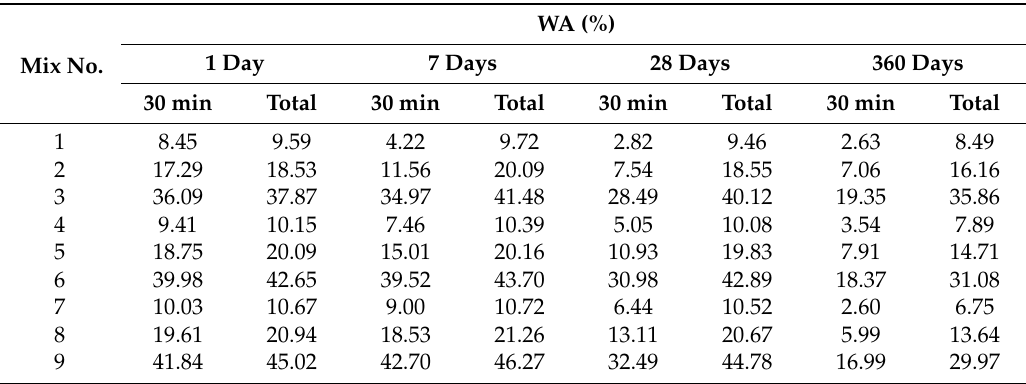
Table 5. Total and 30 min WA of concrete at different